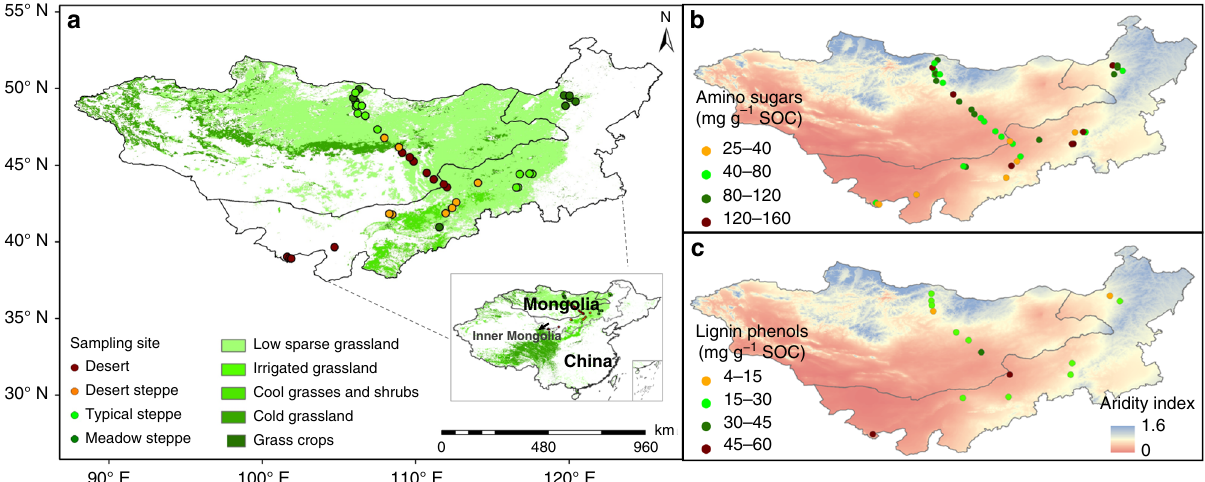
Fig. 1 Sampling sites and biomarker concentrations. Spatial distribution of sampling sites across the Mongolian grasslands ( a ) and soil organic carbon (SOC)-normalized concentrations of amino sugars ( b ) and lignin phenols ( c ) in the surface soils. Land cover classi fi cation is based on the Global Land Cover Characteristics Database v2.0 (https://lta.cr.usgs.gov/GLCC). Data for aridity index are obtained from Global Aridity and PET Database